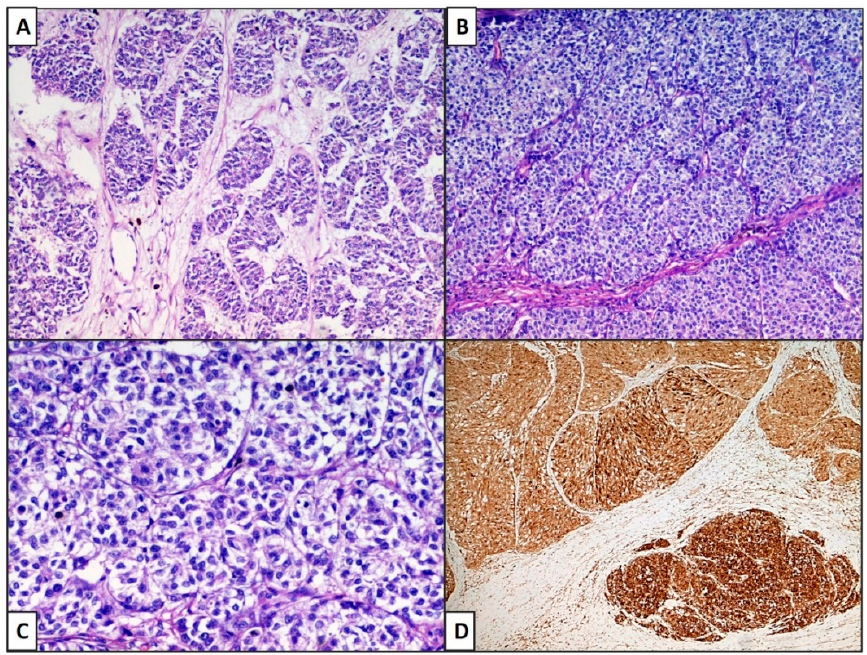
Figure 2. ( A ) Case 1: Neoplastic cells were gathered in very long and intertwined cords, some- times in elaborated nests or alveolar or insular (organoid) structures. ( B ) Case 2,3: In these cases, there were ribbons, trabeculae and cords of neoplastic cells closely packed together (zellballen pattern). Cytologically, the cells are large, sometimes with pale eosinophilic cytoplasm, but also with clear features ( C ) Case 2: (Hematoxylin–Eosin, Original Magnification 100×). ( D ) Cases 1–3: Melan-A was strongly positive in neoplastic cells. (IHC, original magnification